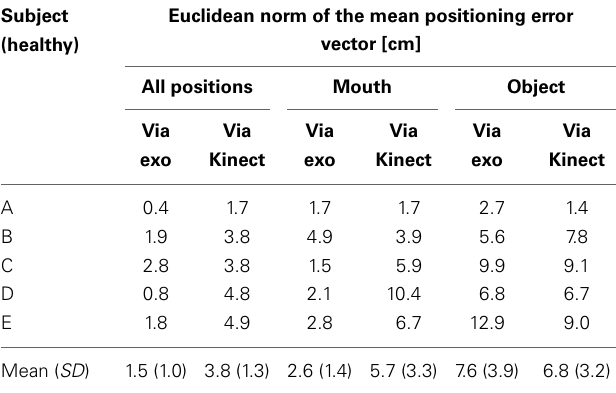
Table 3 | Euclidean norm (distance) of the mean positioning error vector given in Table